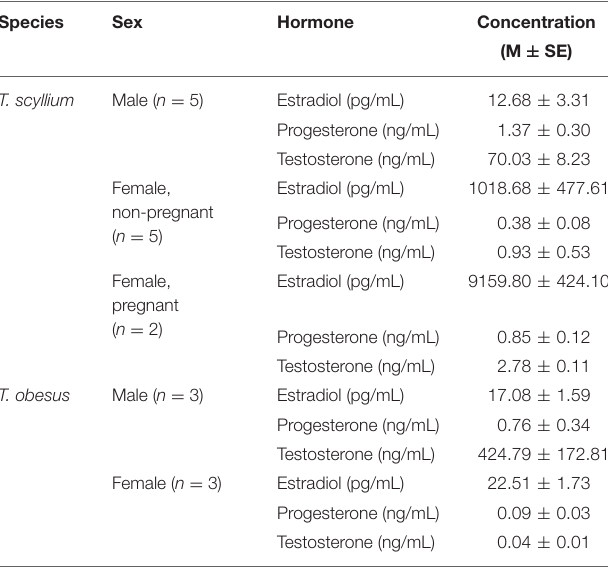
TABLE 1 | Hormone concentrations of Triakis scyllium and Triaenodon obesus prior to Ovaprim ® administration. Species Sex Hormone